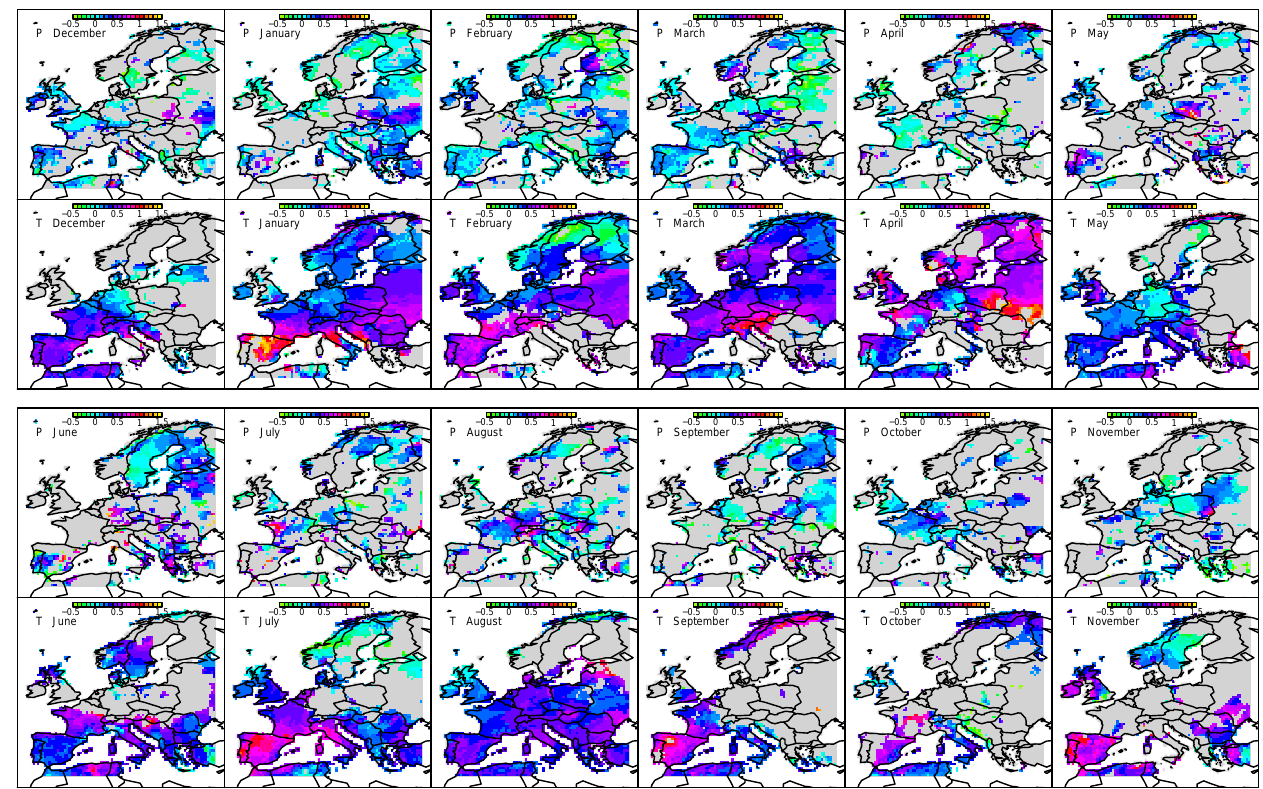
Figure 7. Monthly trend ratios for trends within the groups of dry STs for precipitation (rows 1 and 3) and temperature (rows 2 and 4).